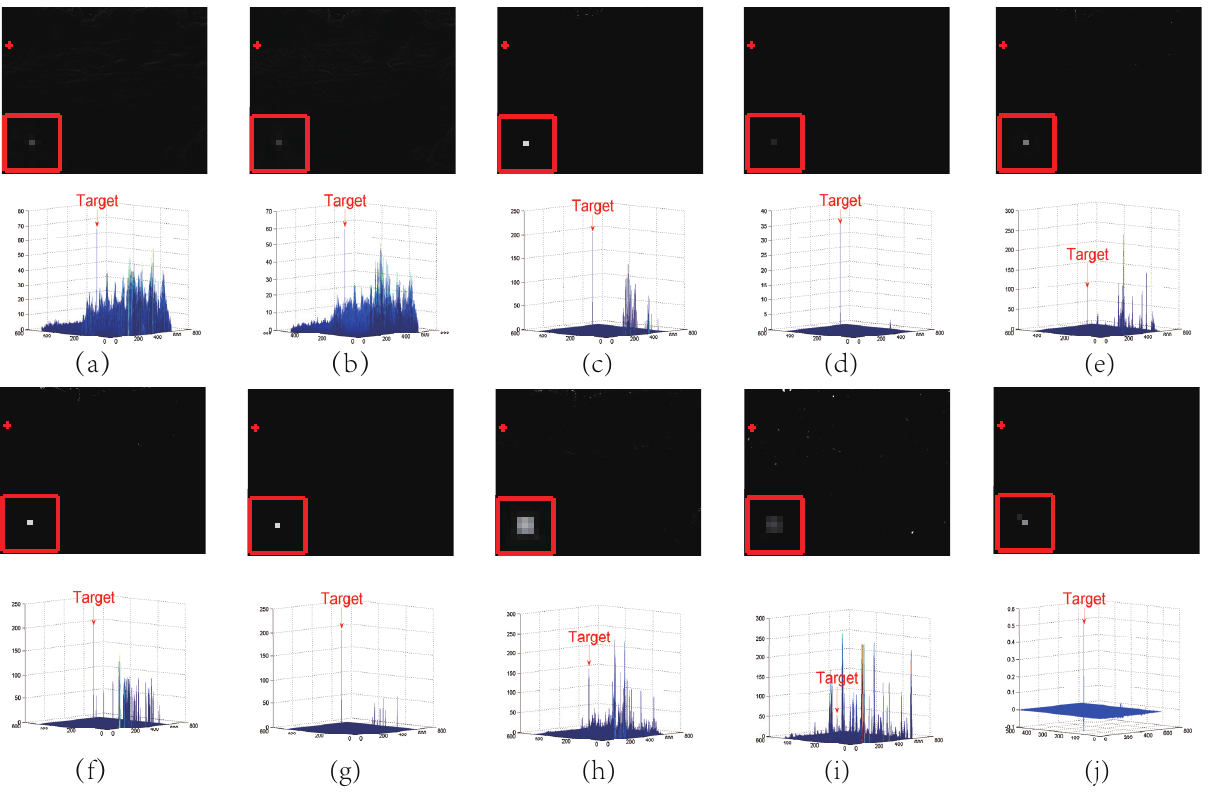
Figure 5. ( a – j ): Top hat, ANI, PSTNN, ASTTV, GST, NTFRA, NRAM, HB-MLCM, ADMD, and the proposed method’s difference diagram and three-dimensional diagram in scene A, respectively.